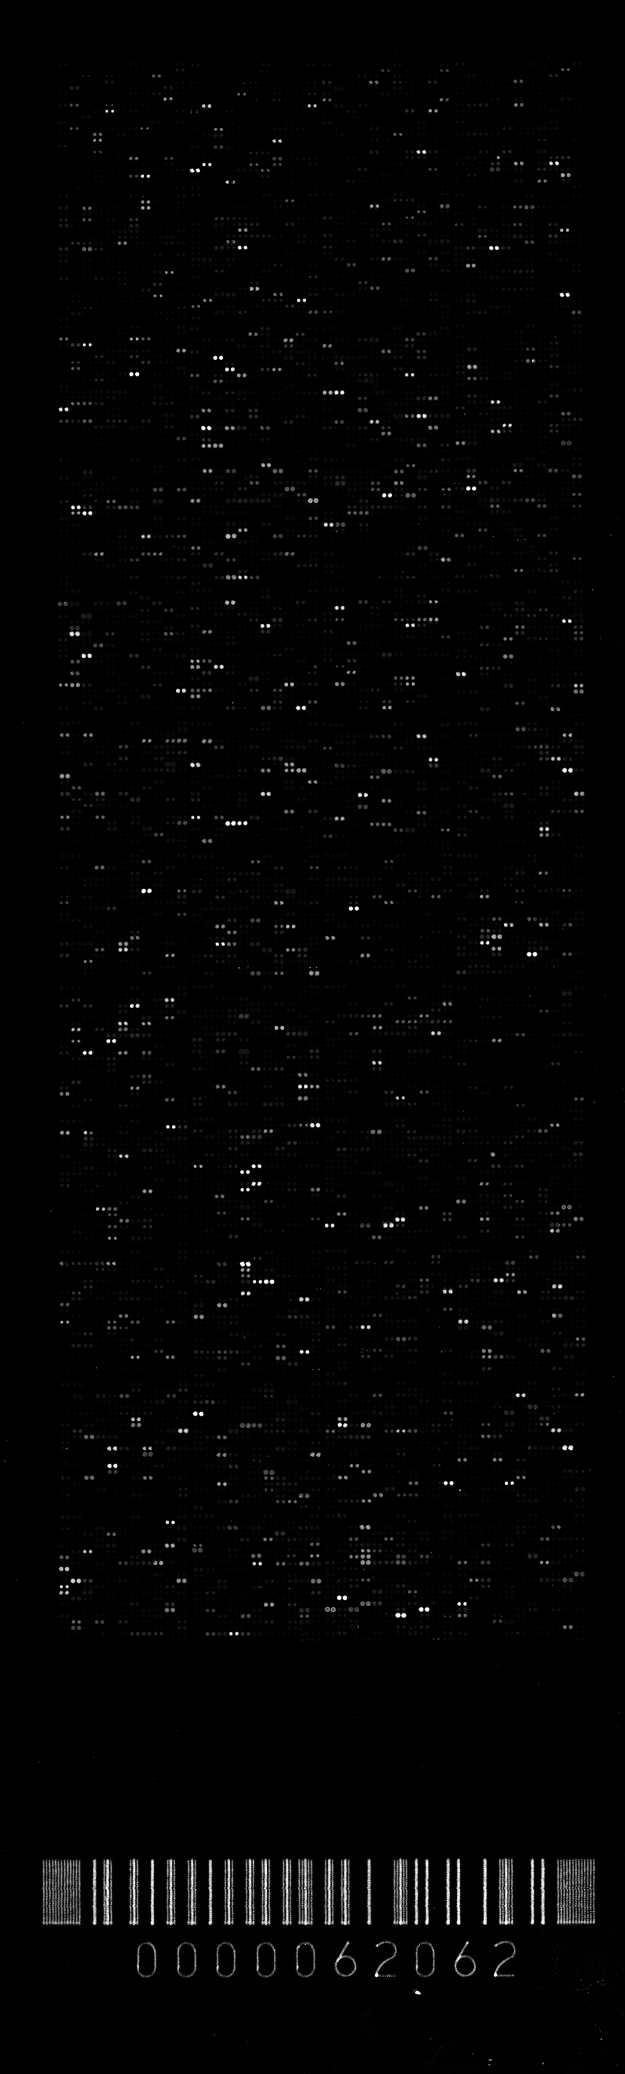
High Resolution Array Image. Experimental assay with G4-3, profiled at 2.5 μM.